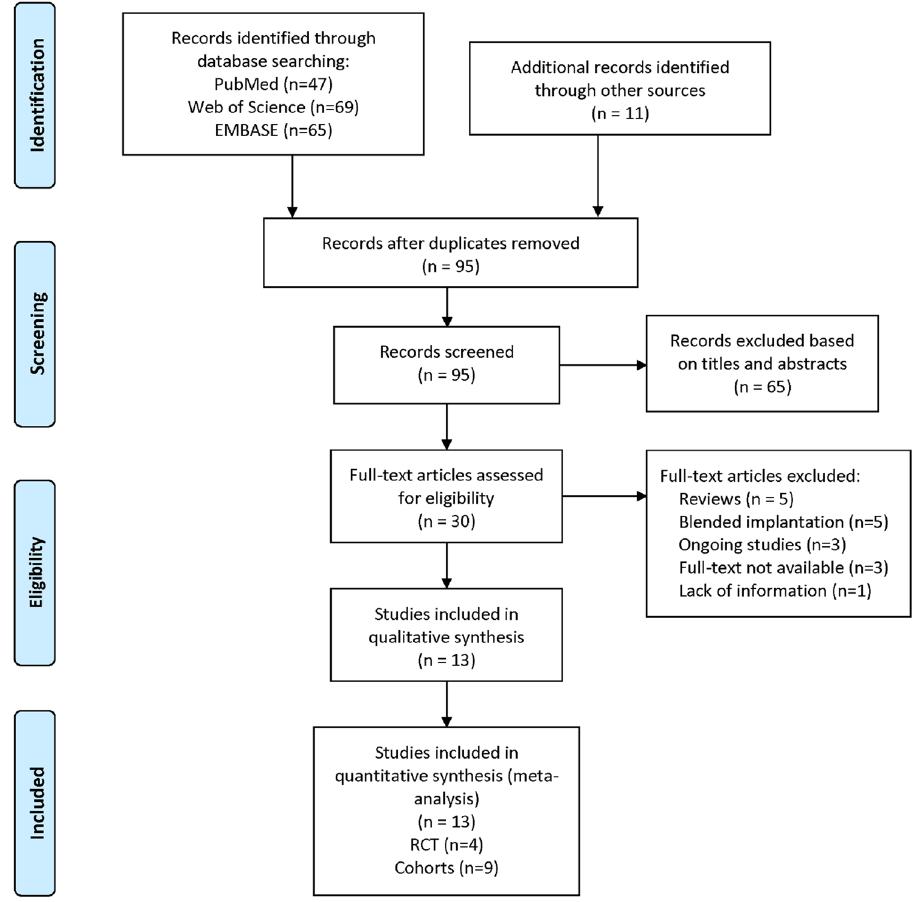
Figure 1. Flow chart depicting selection of studies. RCTs, randomized controlled